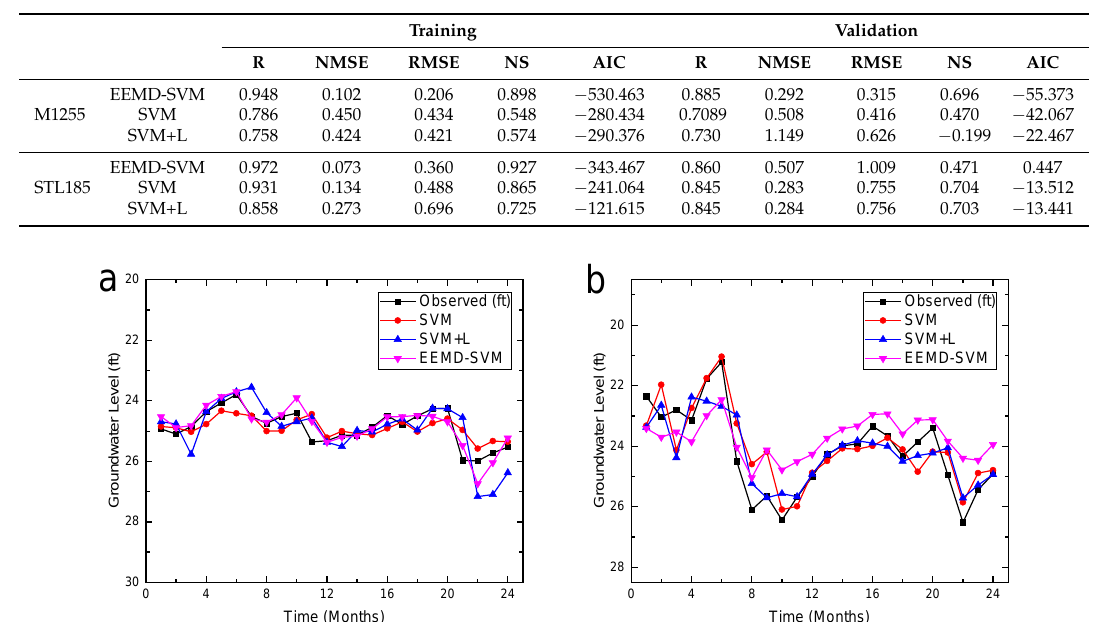
Figure 12. Observed and predicted groundwater levels using SVM, SVM+L and EEMD-SVM ( a ) M1255 ( b ) STL185.